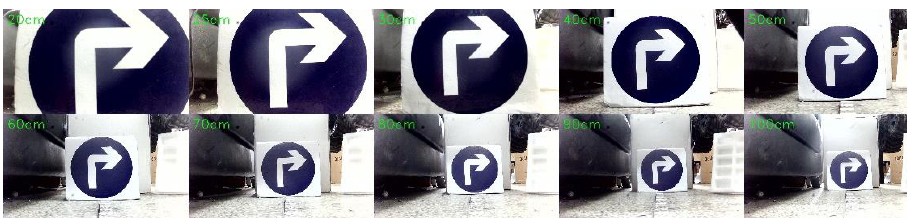
Figure 15. Road sign detection environment. Table 5. Experimental data of short distance road sign recognition.